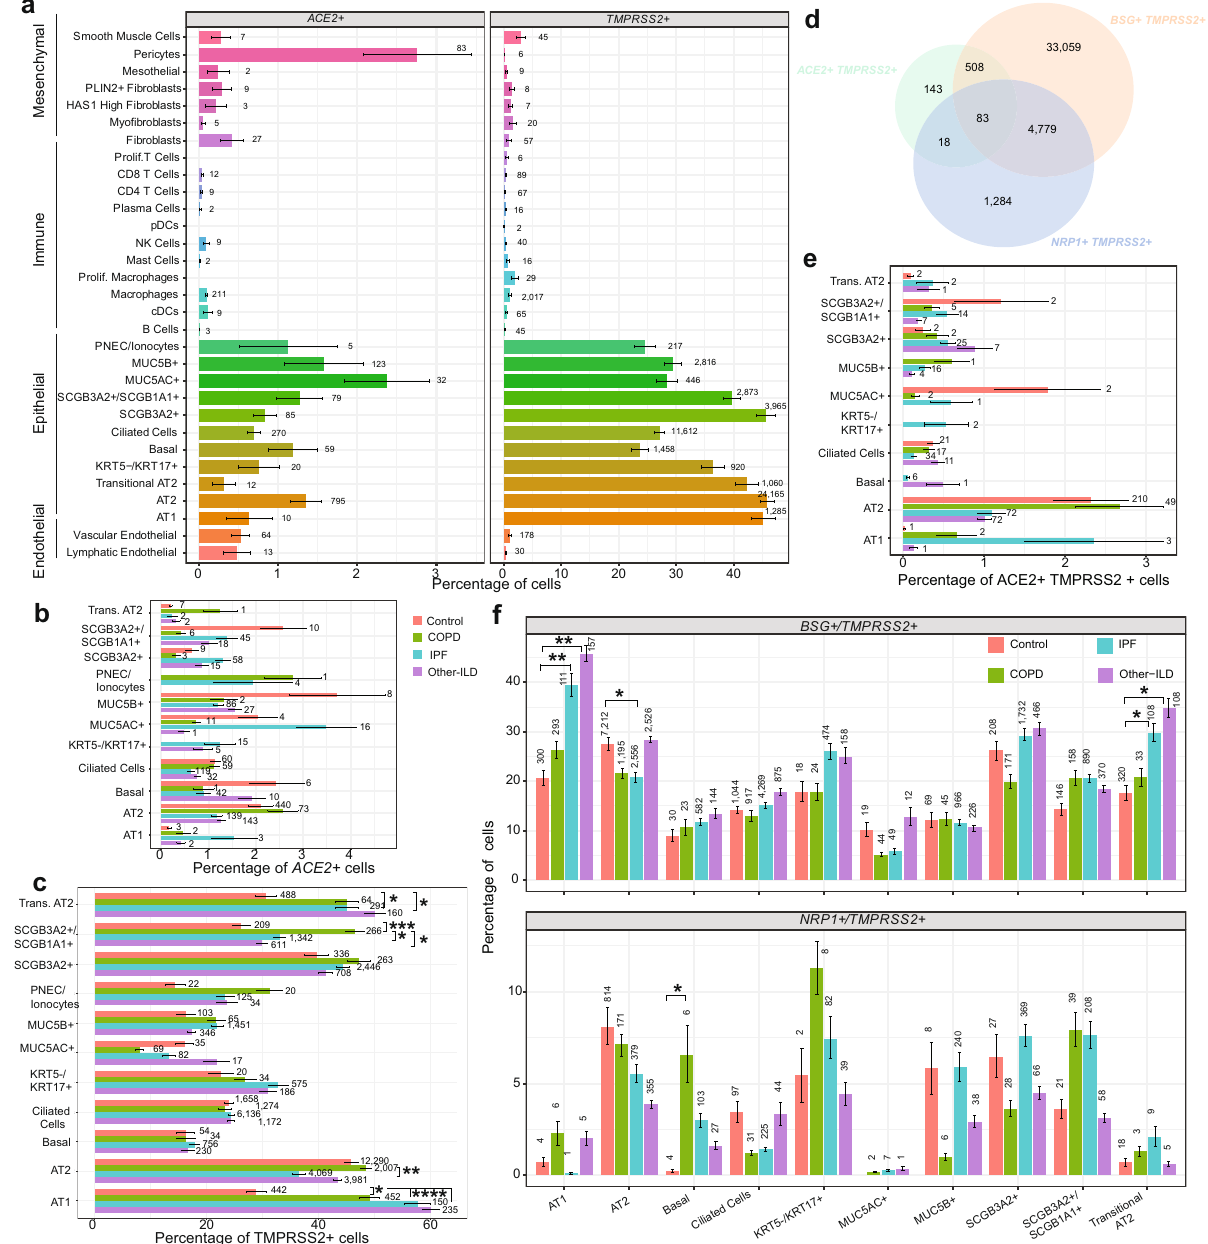
Fig. 1 Percentage of cells expressing SARS-CoV-2 receptor genes in lung cell types in different diagnosis subgroups. a Percentage of cells expressing ACE2 and TMPRSS2 in all cell types. Numbers are the total number of ACE2 + or TMPRSS2 + cells in each cell type in the dataset. b , c Percentage of cells expressing ACE2 ( b ) and TMPRSS2 ( c ) in each diagnosis group in the epithelial cell types. d Venn diagram shows overlapping of cells co-expressing the proposed receptors ( ACE2 , BSG and NRP1 ) and the protease TMPRSS2 . e , f Percentage of cells co-expressing receptors and TMPRSS2 split by cell type and diagnosis group. Plots were generated with mean values of percentage of cells per individual samples, and data are presented as mean values ± SEM. Signi fi cant differences between diagnosis groups were calculated using Tukey_HSD test, p value < 0.05: * p value < 0.01: ** p value < 0.001: *** p value < 0.0001: